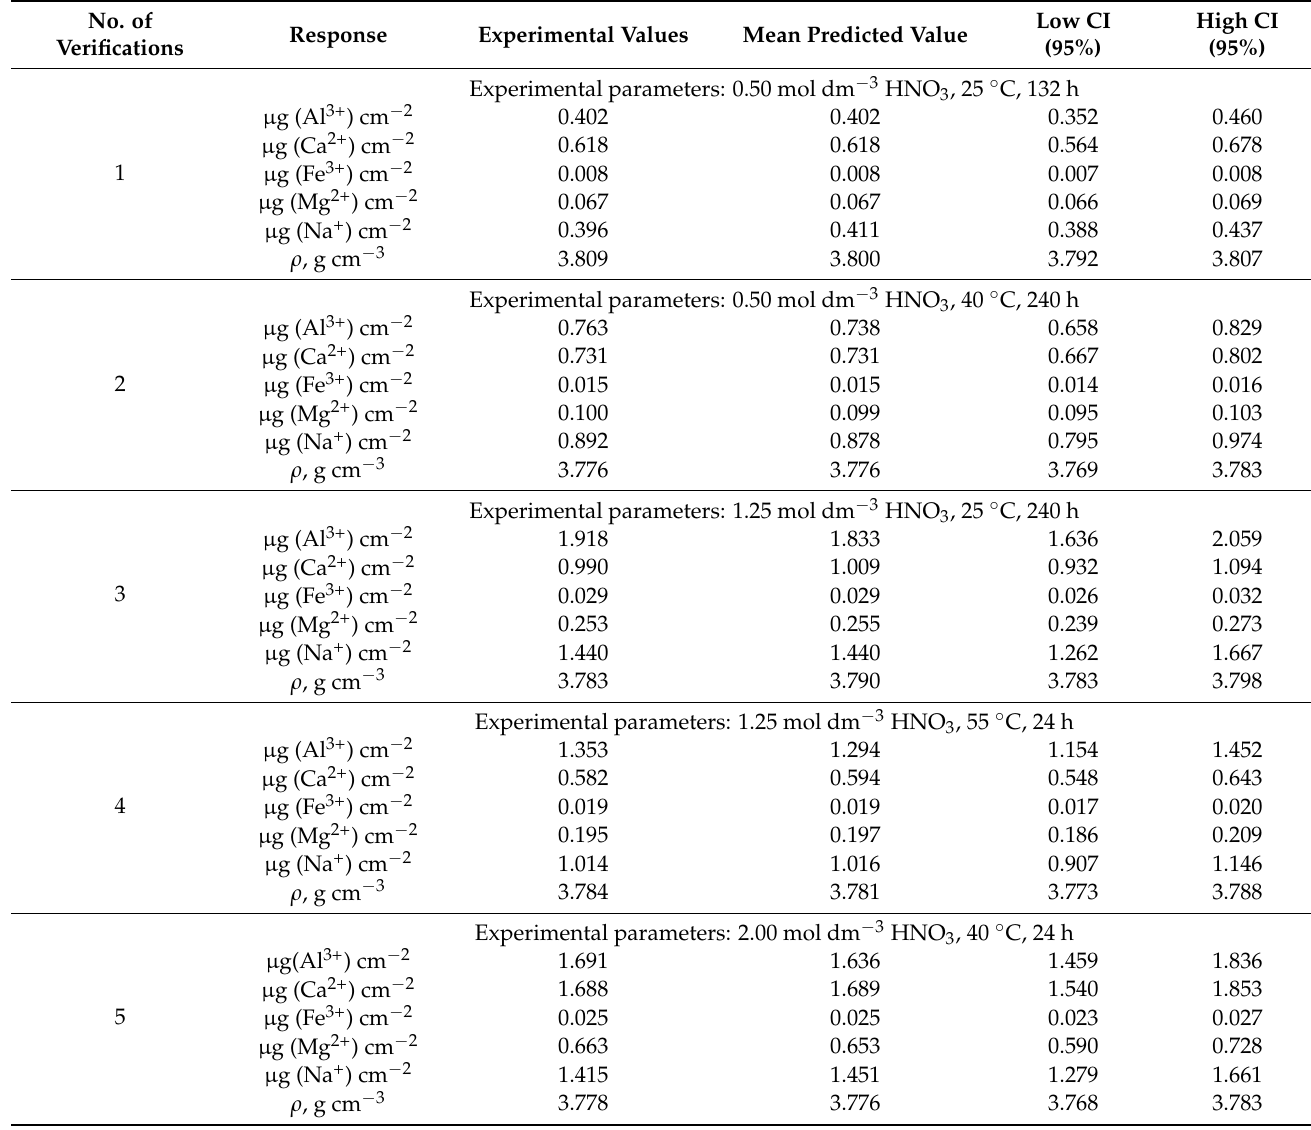
Table 9. Verification of experimental and calculated values of the eluted ion amounts and the density of alumina ceramics at randomly chosen parameters of